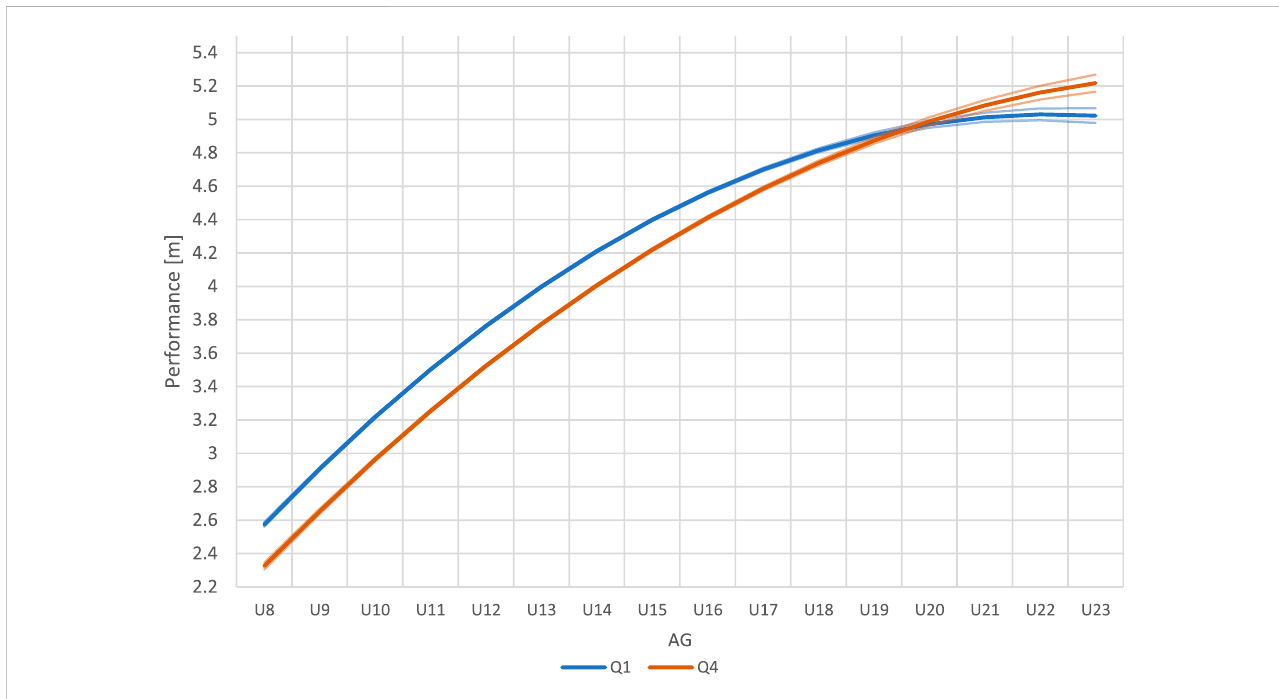
FIGURE 1 Long jump performance of Q1 and Q4 athletes with corresponding 83% con fi dence intervals in annual age groups (AG).